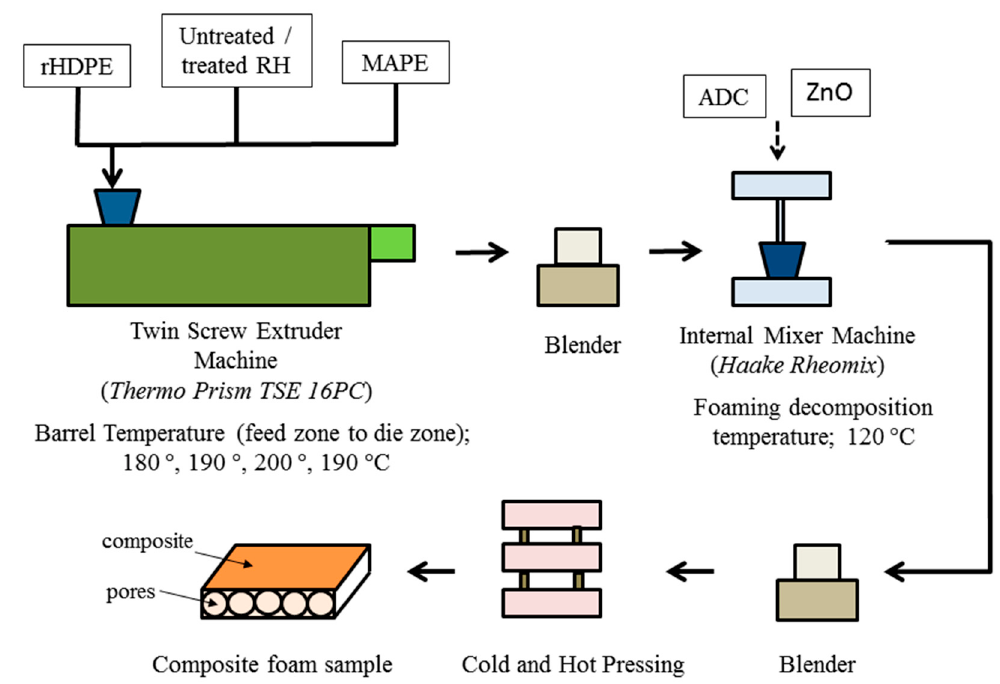
Figure 1. Fabrication of rice husk (RH) / recycled high-density polyethylene (rHDPE) polymer composite foam.